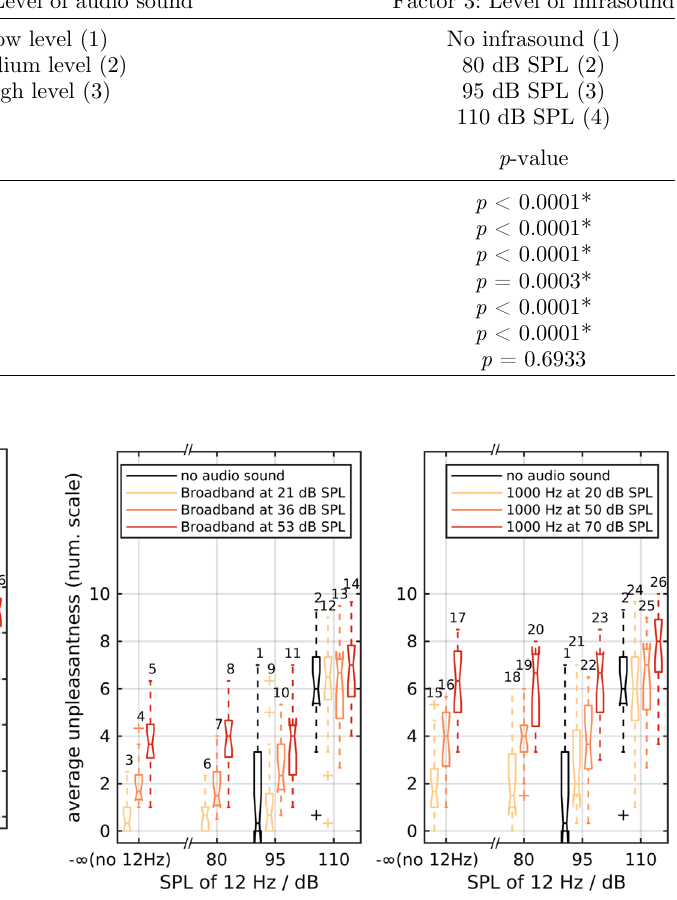
Figure 1. Boxplots of average unpleasantness ratings of 19 participants based on a pairwise comparison test for different stimulus combinations of infrasound and audio sound. The number above each boxplot refers to the stimulus number in